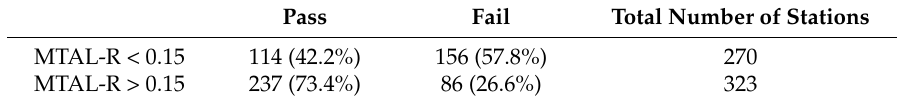
Table 4. Pass/fail rate for all sites and for both cases of MTAL-R less than 0.15 and greater than 0.15. Pass Fail